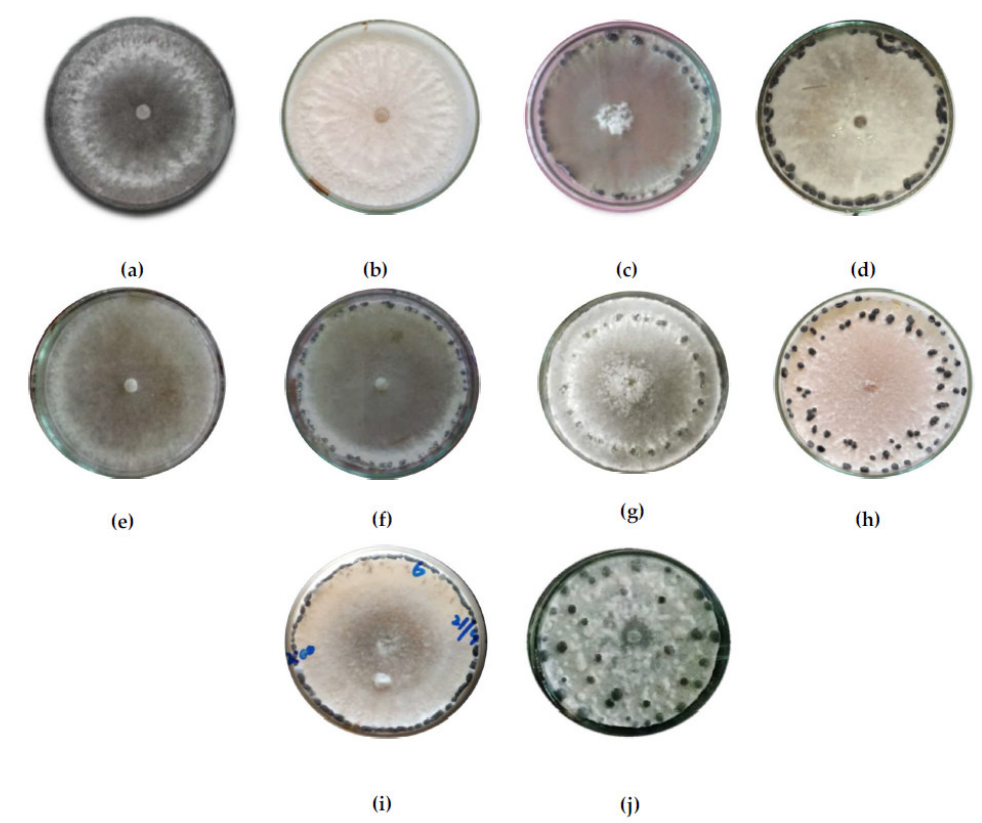
Figure 3. Morph-cultural characteristics: ( a – e ) Colony color and type; ( f – j ) Different sclerotia formation patterns on PDA of S. sclerotiorum isolates. ( a ) off white, fluffy; ( b ) white, fluffy; ( c ) off white, fluffy center; ( d ) white, smooth; ( e ) off white, smooth; ( f ) peripheral; ( g ) sub-peripheral; ( h ) peripheral and sub-peripheral; ( i ) attached to rim; ( j ) scattered.